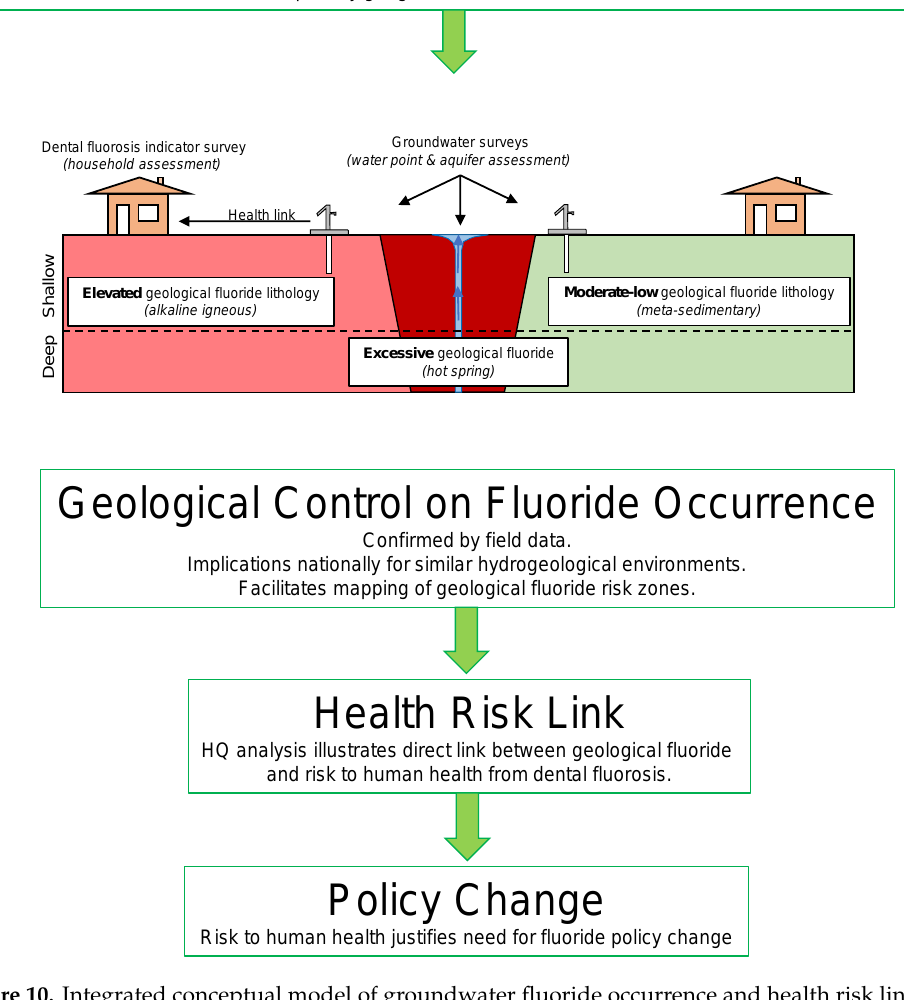
Figure 10. Integrated conceptual model of groundwater fluoride occurrence and health risk linkage leading to advocated groundwater fluoride policy change in